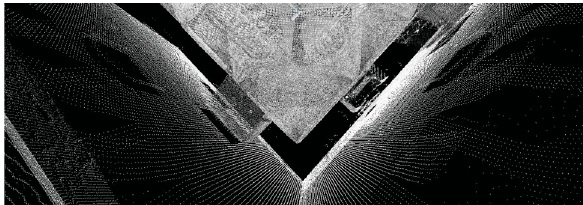
Figure 14. Top view of the point clouds Secondly, orthophotos from the inside and outside walls were overlapped to check if the internal damage had affected the outside area as well: it was soon clear that the damage occurred on a bricked up window on the wall.